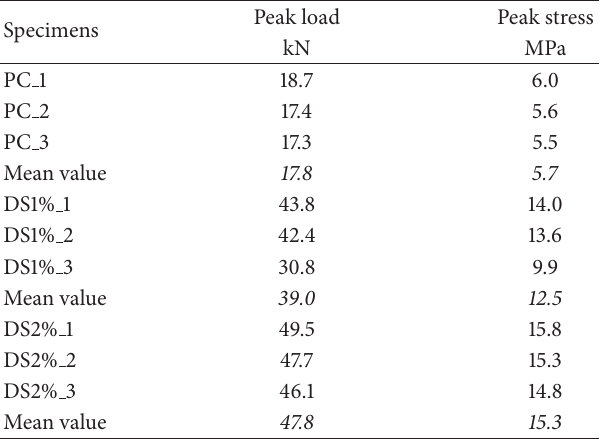
Table 5: Peak loads and strength factors for three-point and four- point bending